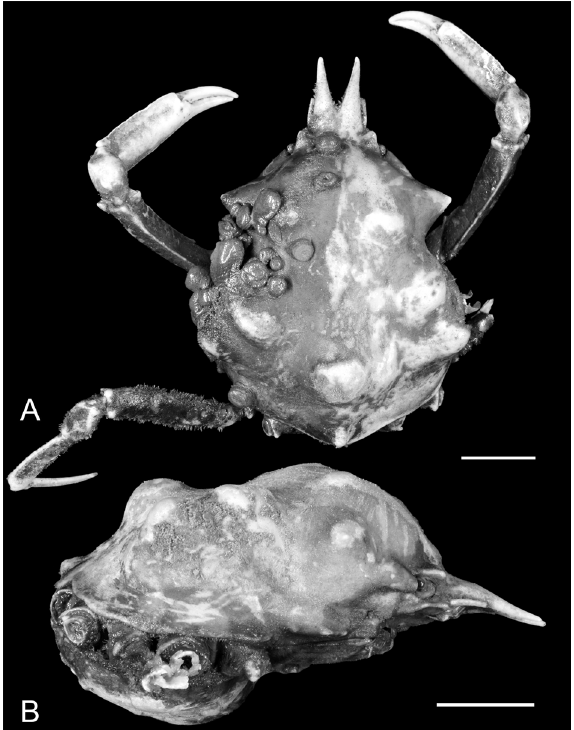
Fig. 1. Goniopugettia sagamiensis (Gordon, 1930), ♀ (41.8 × 30.1 mm) (ZRC 2016.0064), South China Sea with carapace half cleaned, left side of carapace with zootharian attached. A . Overall dorsal view. B . Lateral view of carapace. Scale bars =